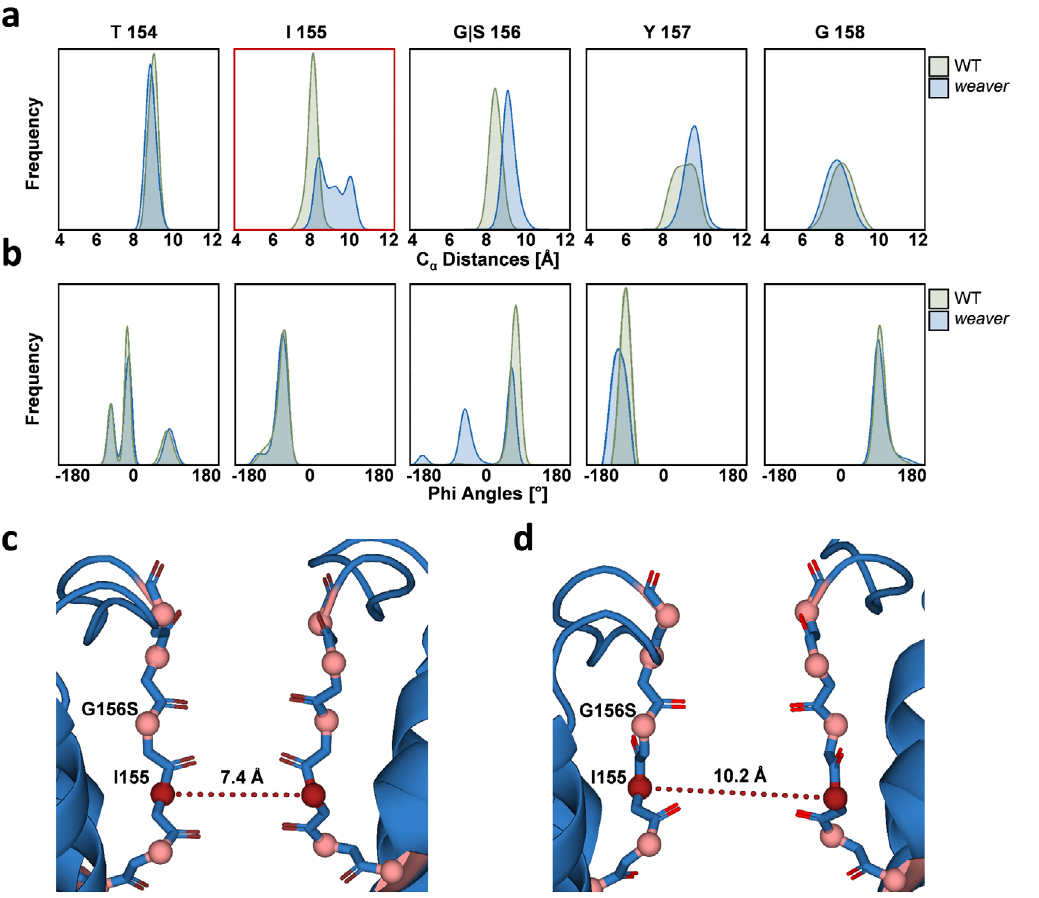
Fig. 6 Structural aberrations in the SF observed over 9 µ s mGIRK2 wv and 6 µ s mGIRK2 wt simulation. a Distributions of distances between C α of opposing mGIRK2 SF residues . b Phi-angle distributions of mGIRK2 SF residues. c and d mGIRK2 wv SF conformations showing the minimum ( c ) and maximum ( d ) distance between opposing I155 C α atoms. The C α atoms of I155 is highlighted are shown in dark red. Other C α atoms of the SF residues are shown as salmon